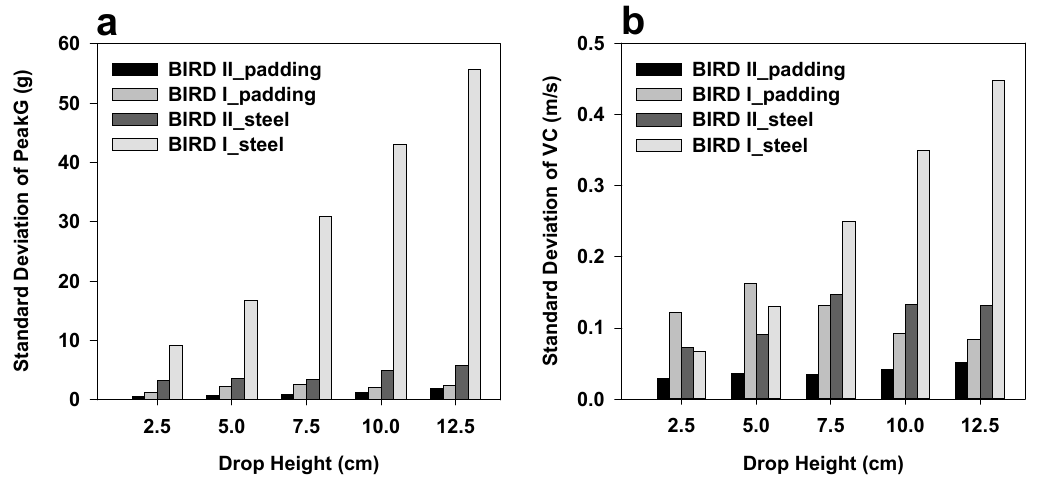
Figure 13. Variance of the dynamic drop measurements by BIRD I and BIRD II. Standard deviation of peakG ( a ) and standard deviation of velocity change (VC) ( b ).